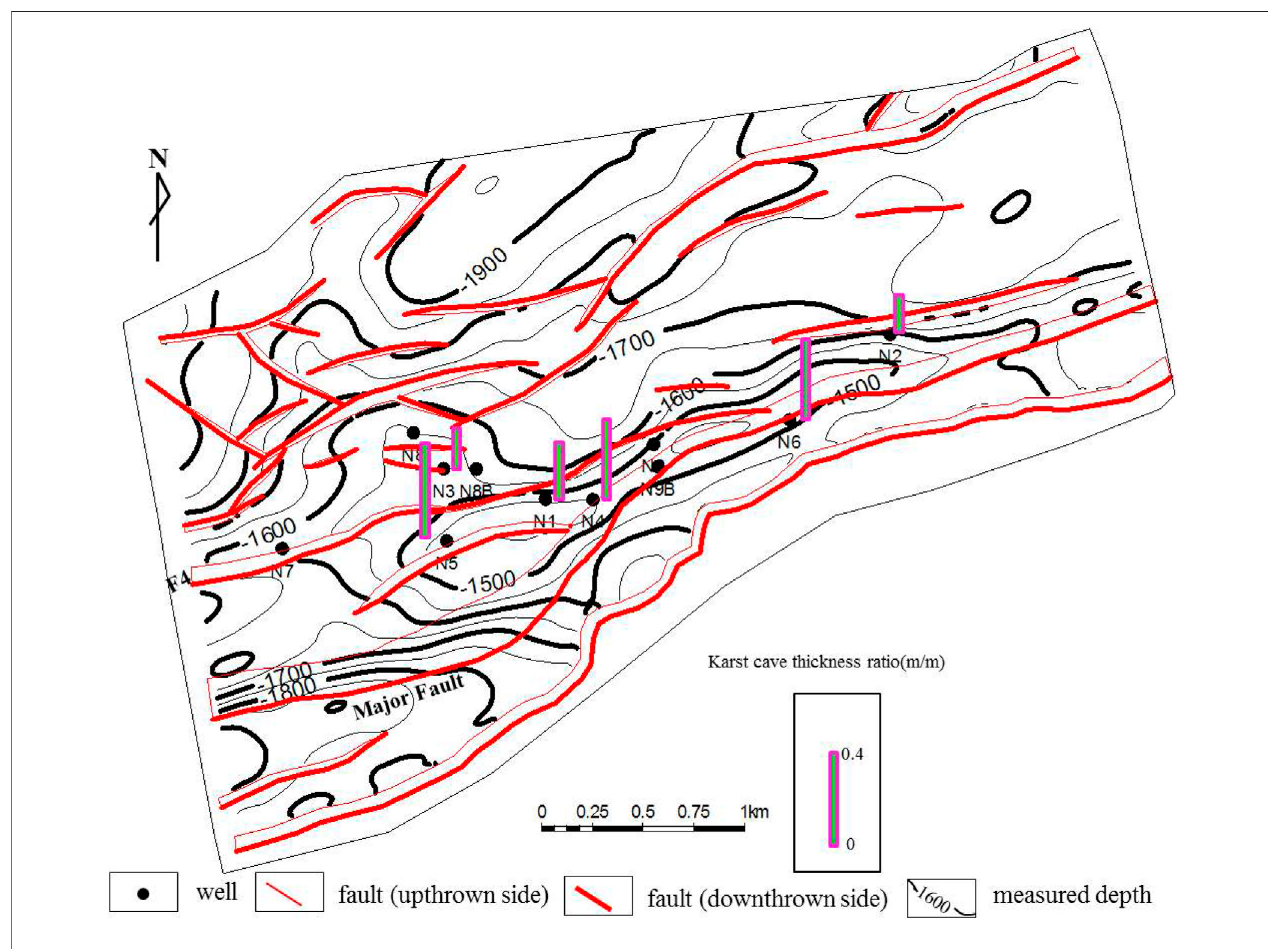
FIGURE 12 | Faults distribution in the Weizhou 1 – N oil fi eld.